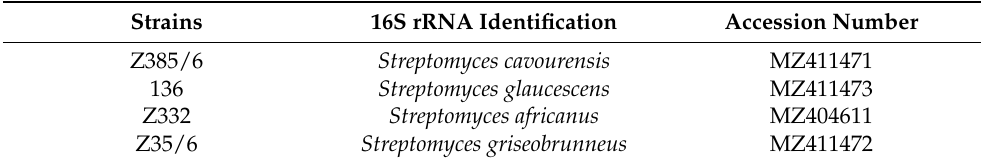
Table 5. 16S rRNA identification of the four selected isolates.